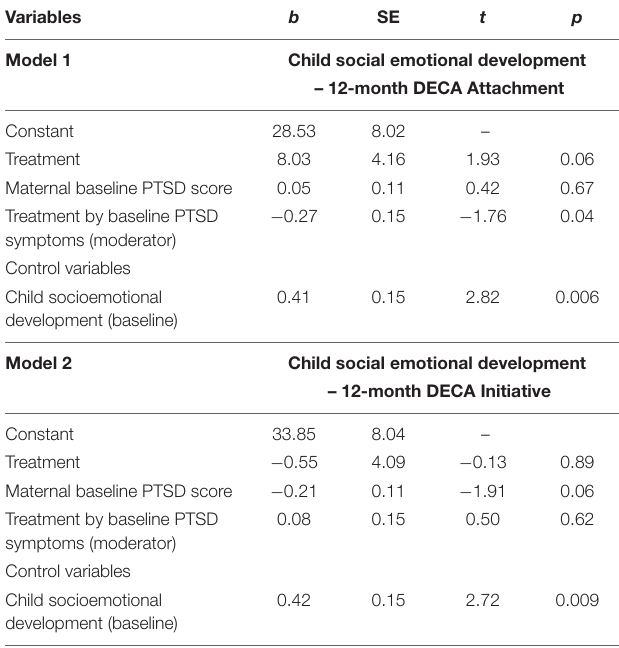
TABLE 4 | Main and interaction effects of maternal PTSD symptoms and intervention on DECA Attachment and Initiative subscales.